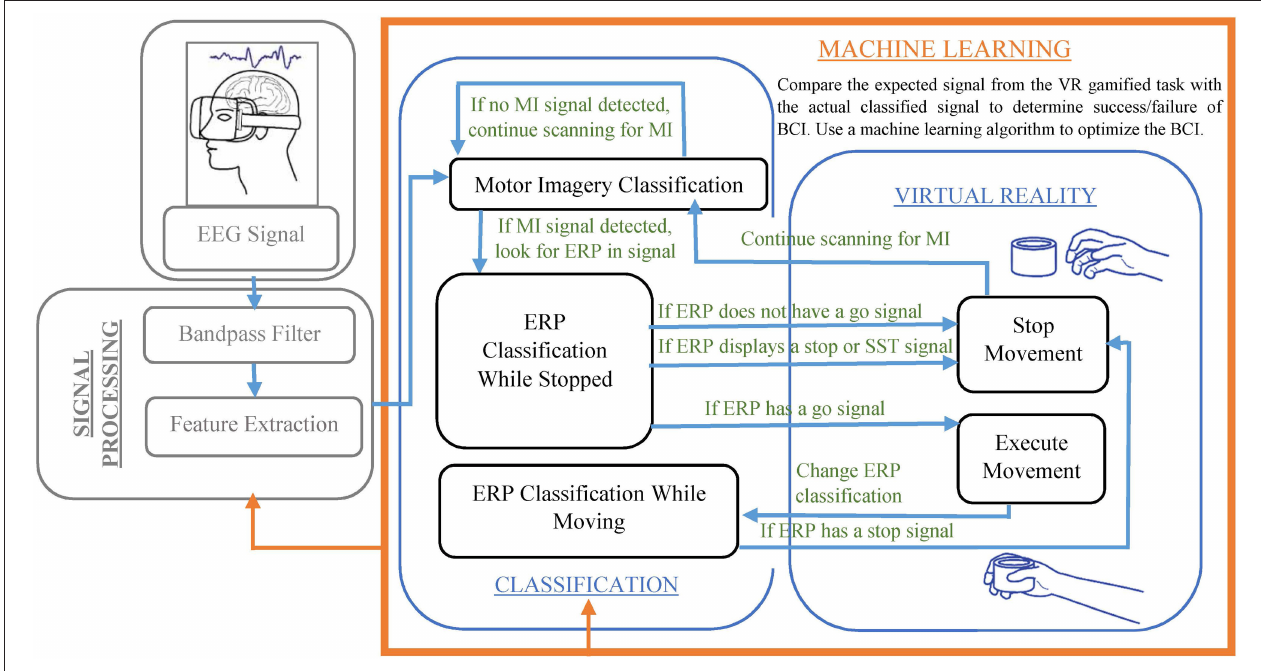
FIGURE 1 | VR training of a hybrid BCI using MI and ERP inputs and a machine learning